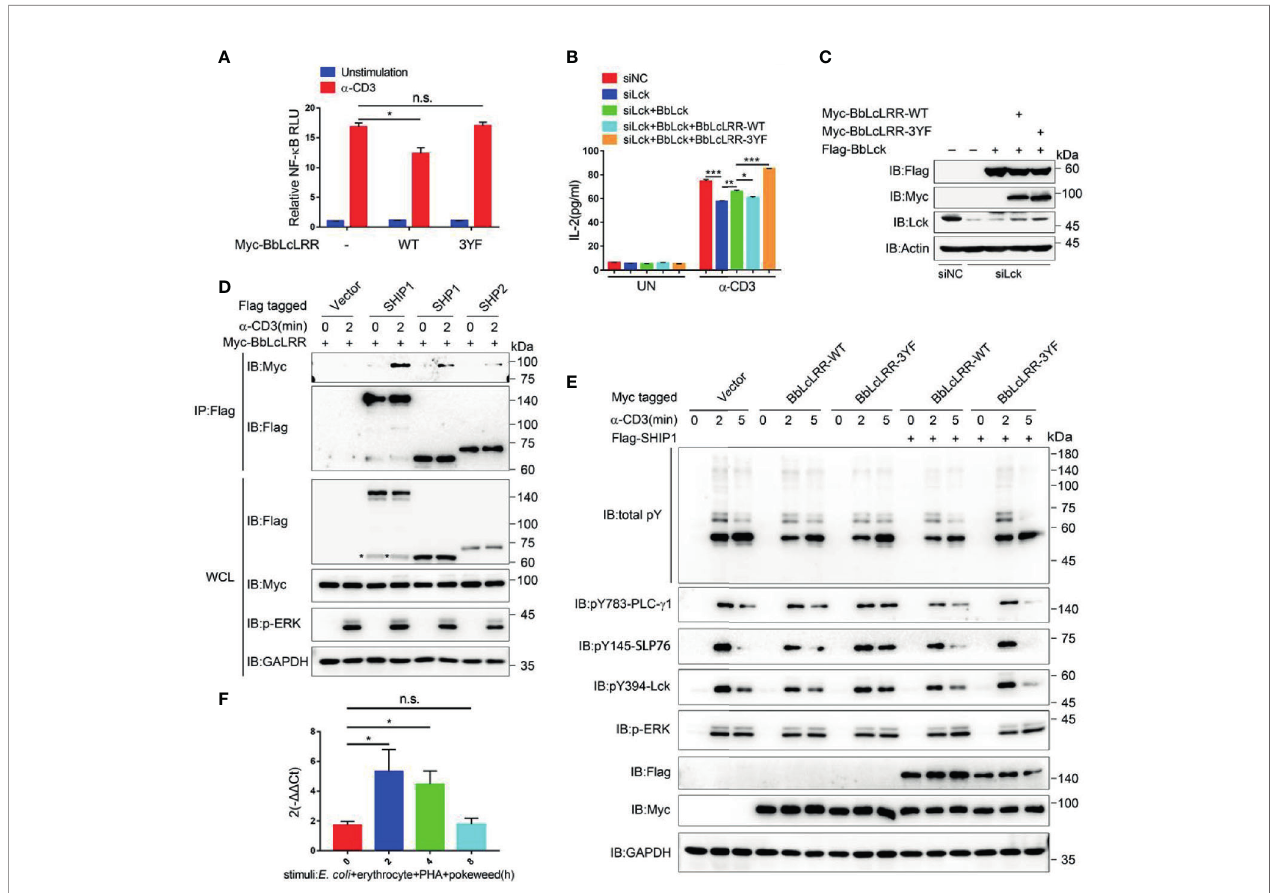
FIGURE 6 | Function analysis of BbLcLRR in Jurkat TAg T cells. (A) Wild-type BbLcLRR, but not 3YF mutant BbLcLRR, inhibited CD3-induced NF- k B activity. 48 hours after cotransfection with the indicated plasmids, luciferase reporter vector driven by an NF- k B-responsive promoter and Renilla luciferase reporter, cells were stimulated with anti-CD3 antibody for 8 h, and relative NF- k B luciferase (NF- k B-Luc) activity was then measured (the NF- k B luciferase activity for vector control unstimulated was set as 1). (B) ELISA of IL-2 production in the culture supernatants of Jurkat TAg cells transfected with negative control (siNC) or siLck together with Flag-BbLck and Myc-BbLcLRR-WT or -3YF as indicated combination, followed by stimulation with anti-CD3 for 24h. (C) The protein expression levels in experiment of (B) . (D) BbLcLRR interaction with SHIP1, SHP1/2. The indicated plasmids were cotransfected into Jurkat TAg T cells. After 48 h, the cells were collected and stimulated with anti-CD3 antibody for the indicated times. Cell lysates were immunoprecipitated by anti-Flag antibody, followed by immunoblotting with indicated antibody. (E) Jurkat TAg T cells were transfected with empty vector, Myc-BbLcLRR-WT or BbLcLRR-3YF together with Flag-SHIP1 or not as indicated for 48 h, followed by stimulation with anti-CD3 for the indicated time. Whole-cell lysates (WCLs) were immunoblotted with the indicated antibodies. (F) Relative expression level of BbLcLRR gene of Branchiostoma belcheri stimulated with E coli (10 5 ), erythrocytes (10 5 ), PHA (15 m g) and pokeweed (20 m g) for various time by qRT-PCR. 2- DD Ct values (normalized to endogenous control 18S) represented the expression of the BbLcLRR gene in Branchiostoma belcheri stimulated various duration. n.s., not signi fi cant; * P < 0.05, ** P < 0.01, and *** P < 0.001 (two-tailed unpaired t -test). The data are presented as the mean (± s.e.m.). Data are representative of at least three independent